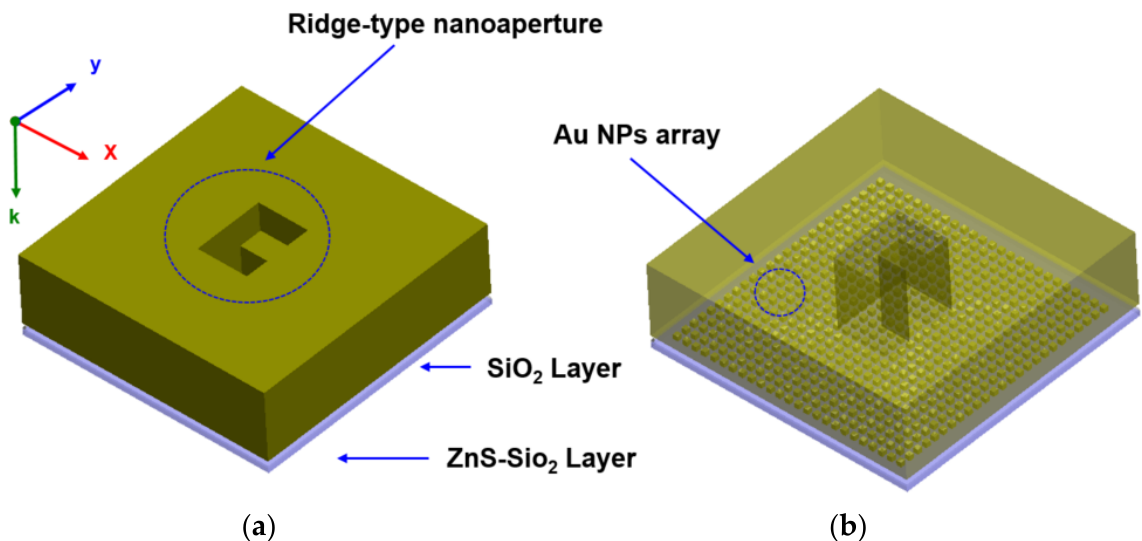
Figure 2. The structural FDTD model of Au NPs array deposited media with ridge-type nanoaperture ( a ) solid view, and ( b ) transparent view.